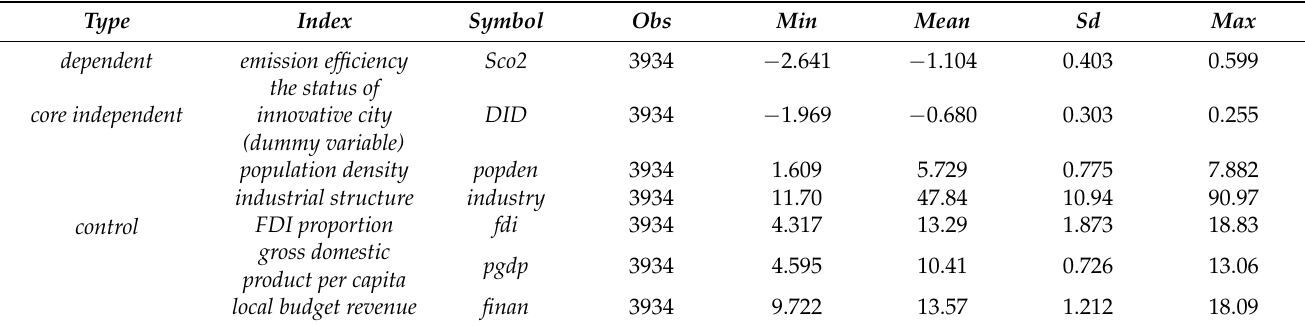
Figure 6. Carbon efficiency distribution of cities in China (2019).